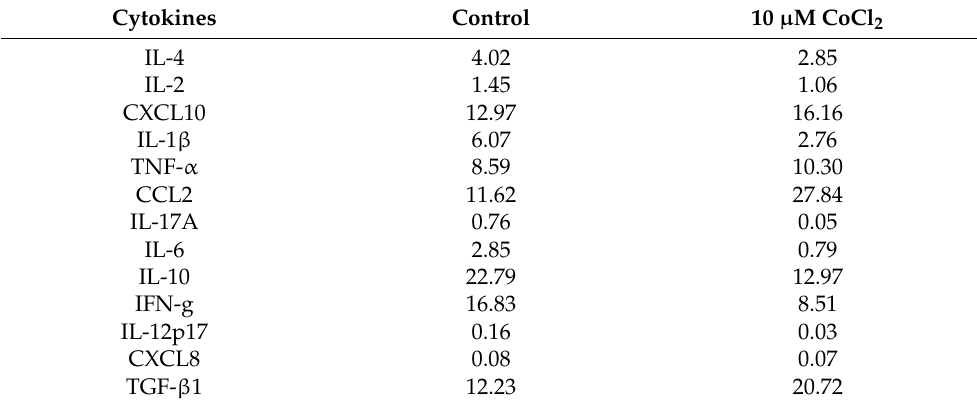
Table 6 . Effect of CoCl 2 on cytokine secretion by DPSCs. Table 6. Effect of CoCl 2 on cytokine secretion by DPSCs.